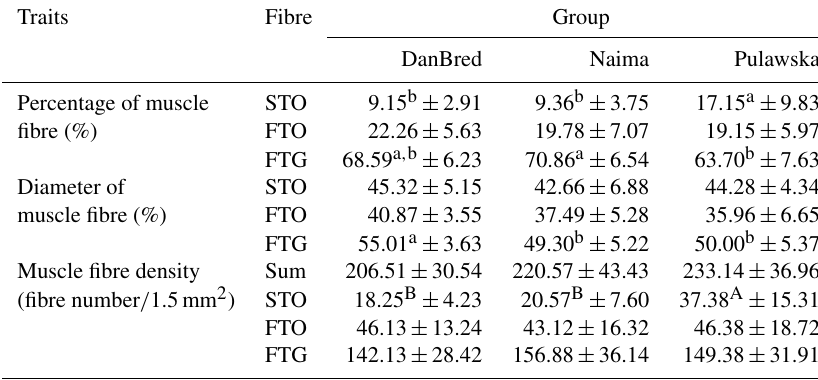
Table 3. Microstructure of the longissimus lumborum muscle in pigs. Traits Fibre Group DanBred Naima Pulawska